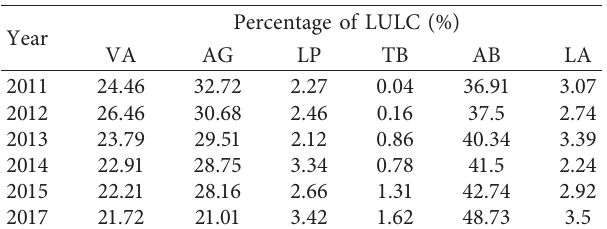
Figure 4: LULC classification of the code river watershed in 2011–2017. Table 3: Proportions of each LULC class in the Code River wa- tershed during